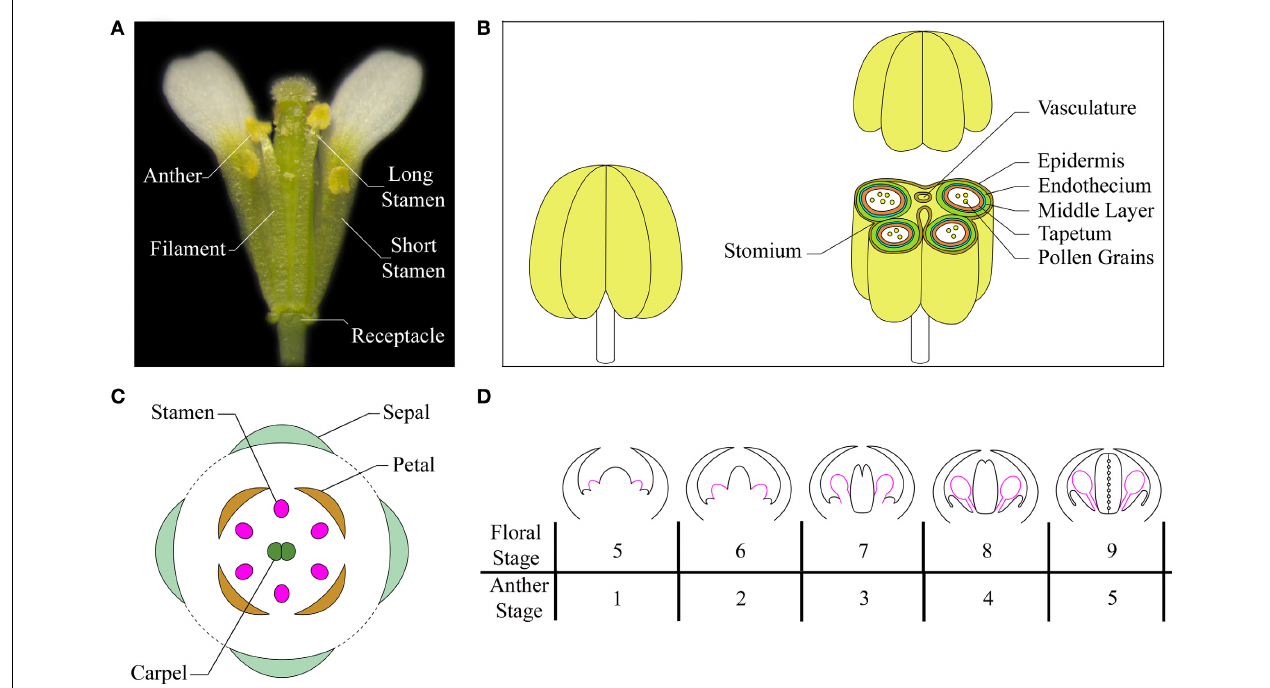
FIGURE 1 | The Arabidopsis stamen. (A) A mature flower at anthesis showing short and long stamens (with the removal of some petals and sepals for visualization). (B) Cartoon of a stamen at a stage after meiosis (left) and of the stamen transverse section, at the level of the anther, with differentiated tissues indicated in different colors (right). Based on Sanders et al. (2000), Jia